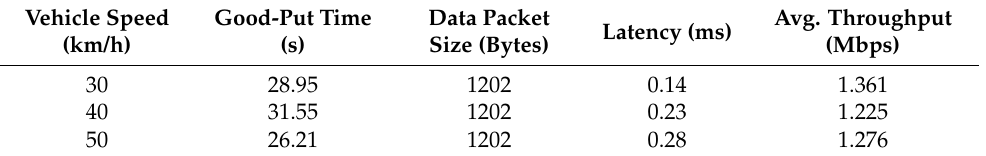
Table 2. Test measurement results for V2I.